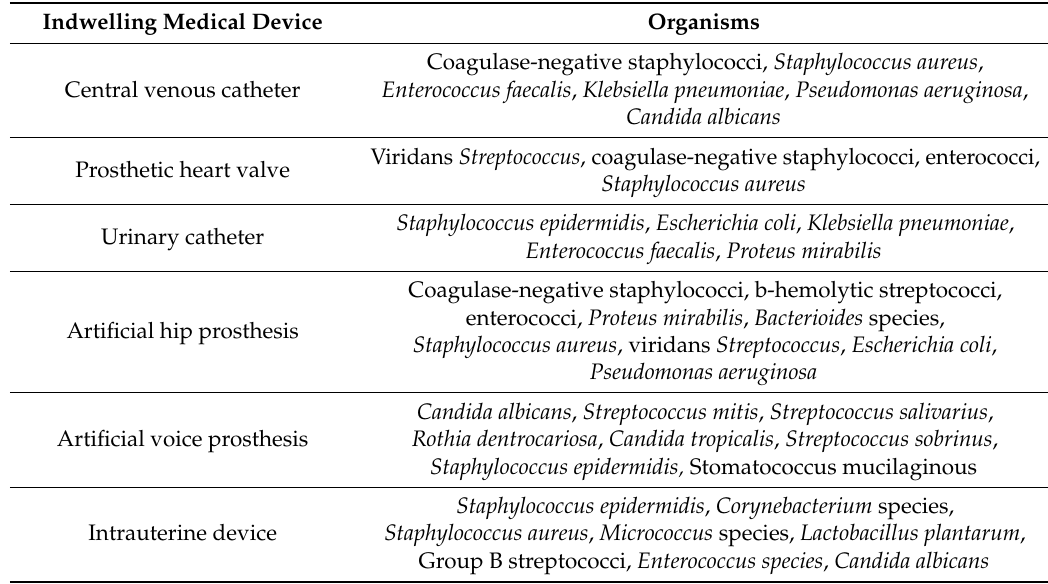
Table 1. Biofilm-associated microorganisms commonly isolated from selected indwelling medical devices [23].